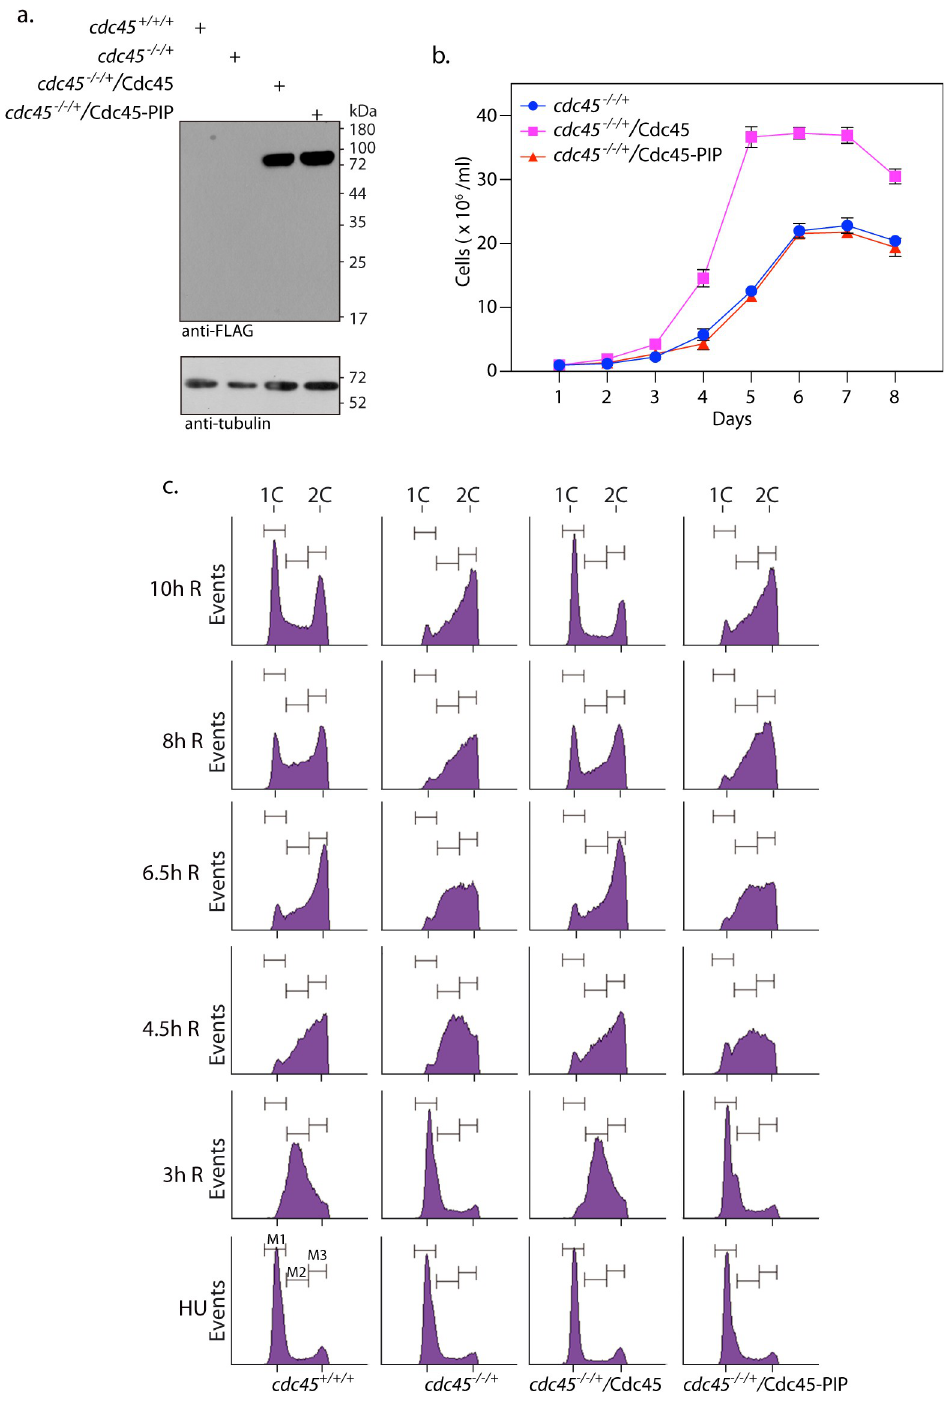
Fig 5. Cdc45-PIP box is essential for Leishmania cell survival. a. Western blot analysis of whole cell lysates isolated from transfectant cdc45 -/-/+ promastigotes expressing Cdc45-FLAG or Cdc45-PIP-FLAG. b. Analysis of growth patterns of transfectant cdc45 -/-/+ promastigotes expressing Cdc45-FLAG or Cdc45-PIP-FLAG. Graph presents averages of three experiments with error bars indicating standard deviation. c. Flow cytometry analysis of transfectant cdc45 -/-/+ promastigotes expressing Cdc45-FLAG or Cdc45-PIP-FLAG. The experiment was performed thrice, and the data from one experiment is presented here. 30000 events were analyzed at every sampling. Sampling times are indicated along the y axes and cell types are indicated below the histogram columns. cdc45 +/+/+ —Ld1S::neo-hyg-bleo cells.